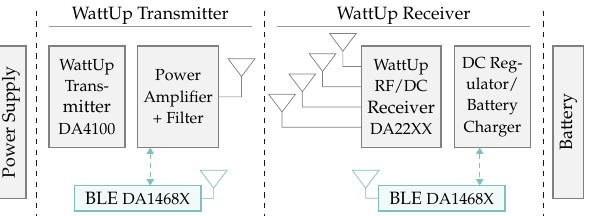
Figure 31. The near-field WattUp system consists of a Wattup-compatible transmitter and receiver. An optional BLE connection enables communication between both, for example, communicating the battery status information